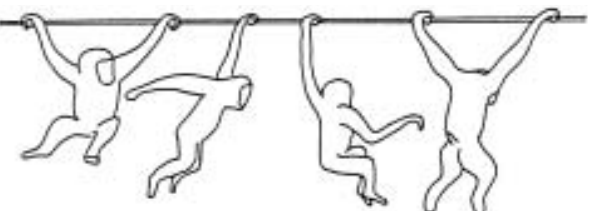
Figure 1 Gibbon locomotion.